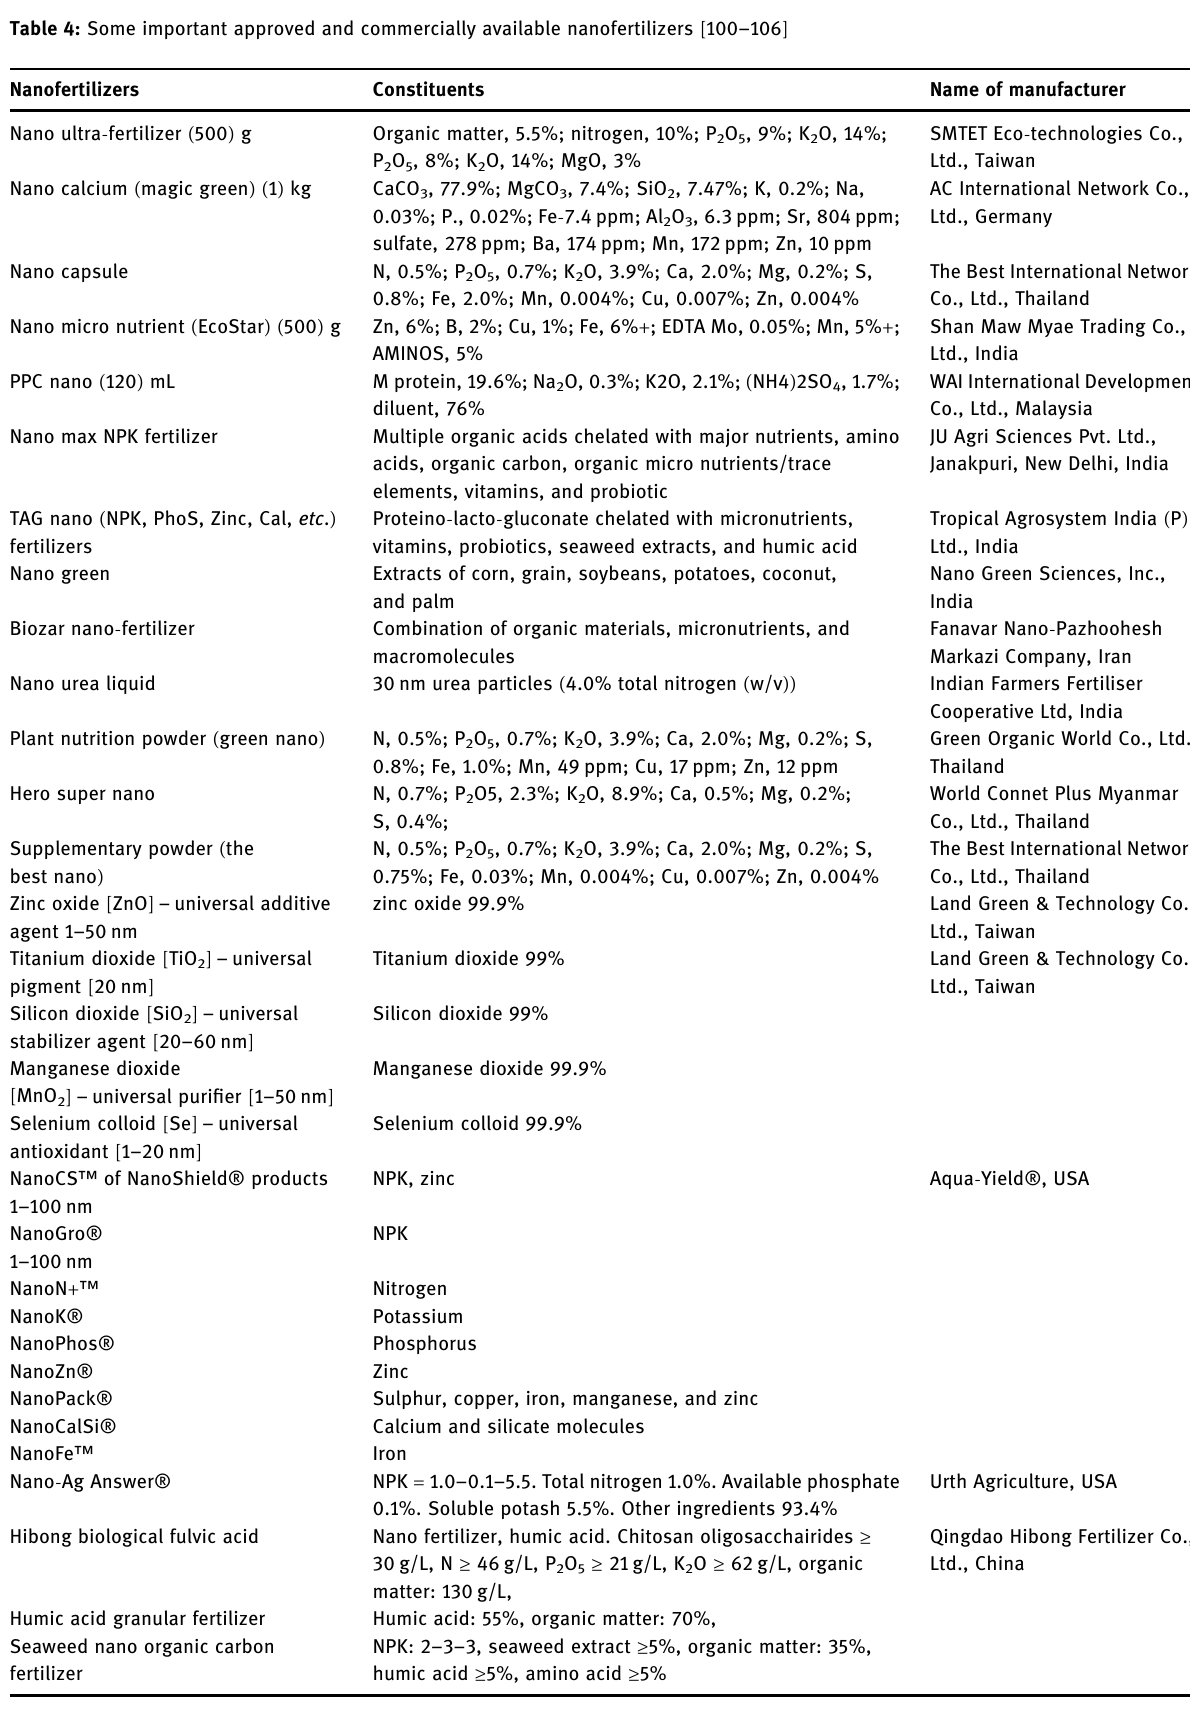
Table 4: Some important approved and commercially available nanofertilizers [ 100 – 106 ]